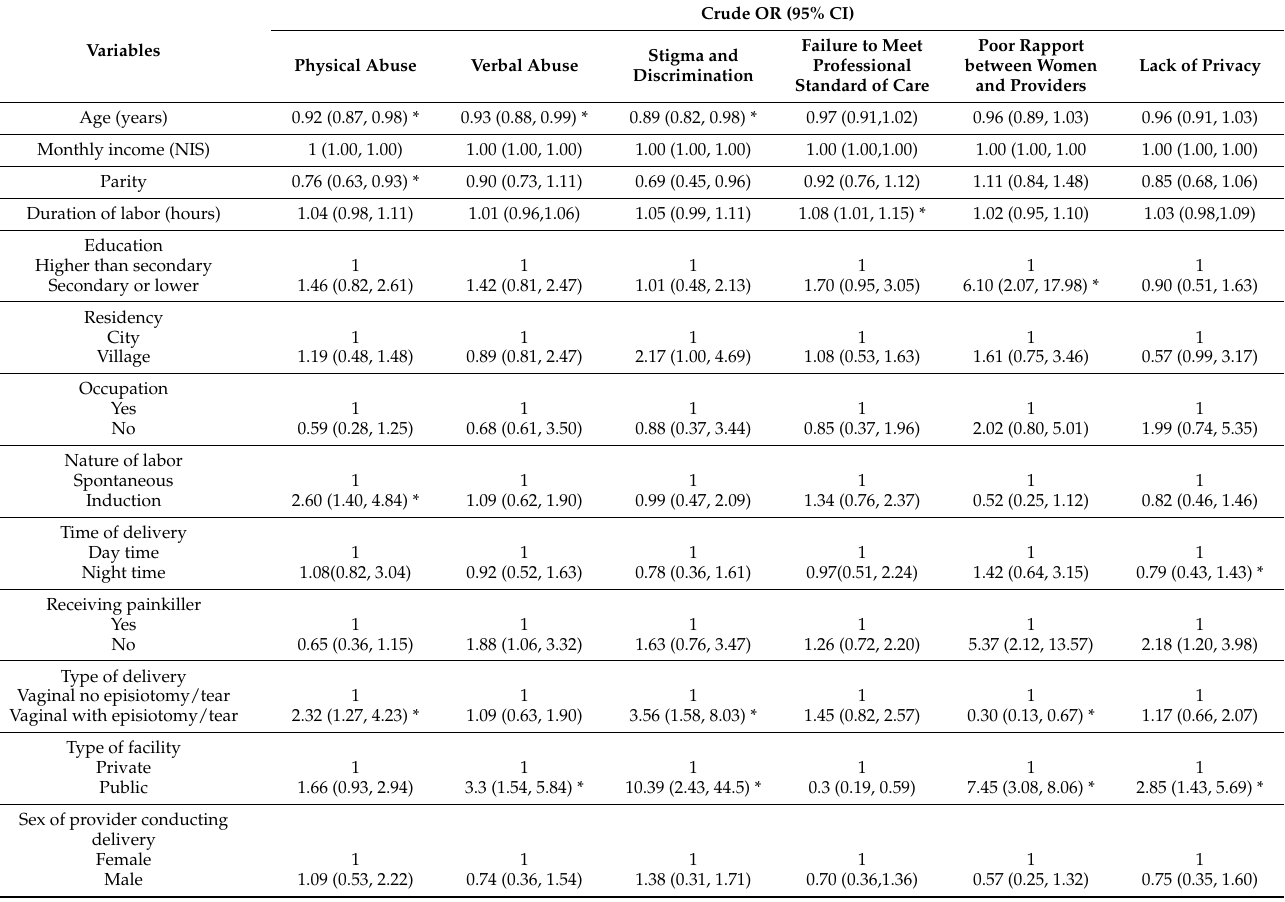
Table 5. Simple logistic regression analysis for 13 factors associated with the six types of mistreatment at p -value < 0.25.